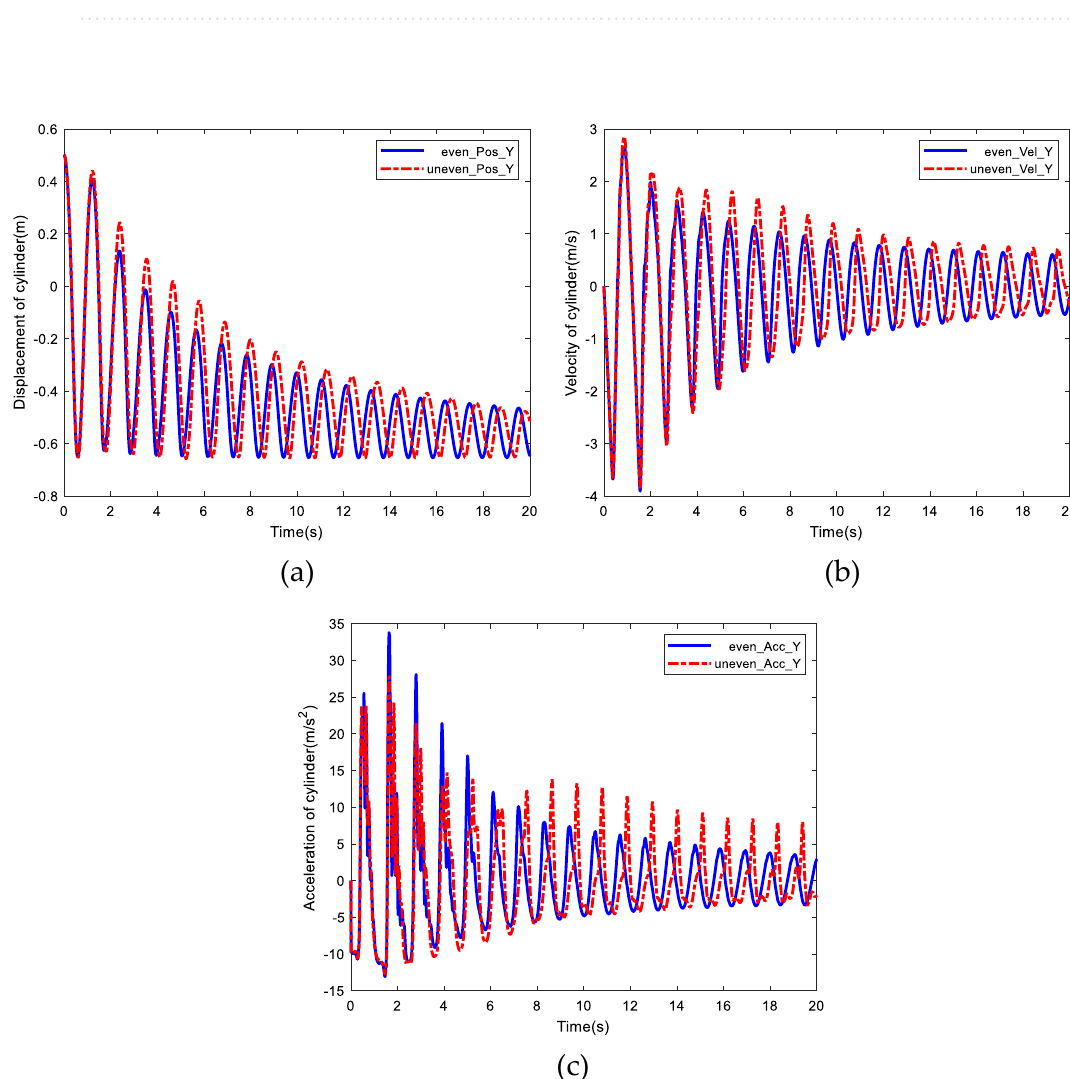
Figure 15. Comparison of equidistant and non-equidistant distribution of rigid bodies. ( a ) Comparison of displacement. ( b ) Comparison of velocity. ( c ) Comparison of